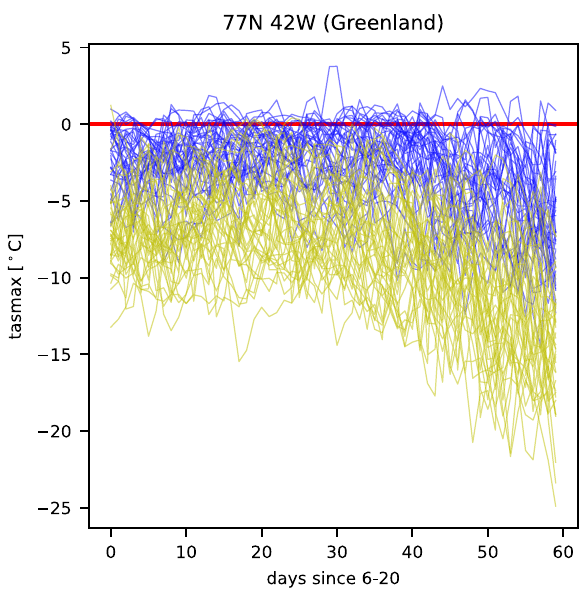
Fig. 7 Correlation between heatwaves and blocking varies insigni fi cantly in the future over continents north of 40°N and Europe. Cross-validation R 2 of 13 CMIP6 models over different regions are shown for historical (yellow, 1966 – 2005) and SSP585 (blue, 2060 – 2099). Bigger crosses show the multi-model mean. R 2 decreases signi fi cantly in the future over Greenland, perhaps because of the scarcity of future